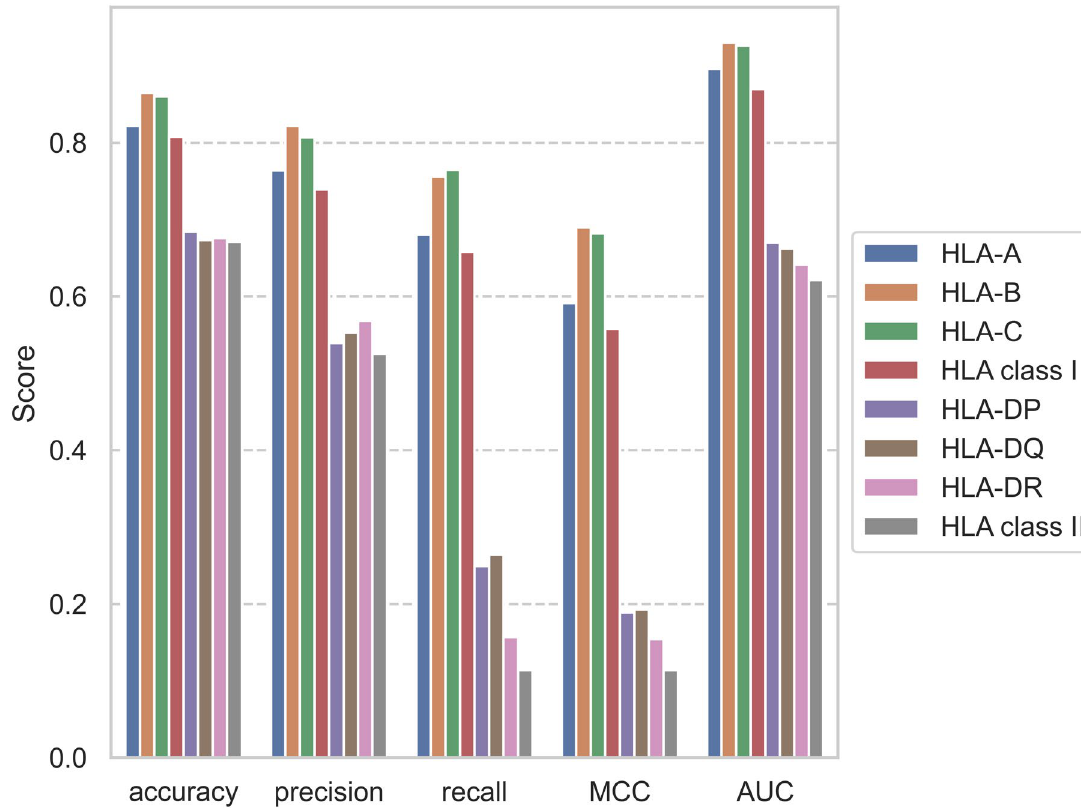
Figure 3. Statistical scores of the NetCleave models on six human allele isotypes (HLA-A, -B, -C, -DP, -DQ and -DR) and two human allele classes (HLA class I and II), including accuracy, precision, recall, MCC and AUC. A threshold of 0.5 was defined to compute the classification statistic scores.